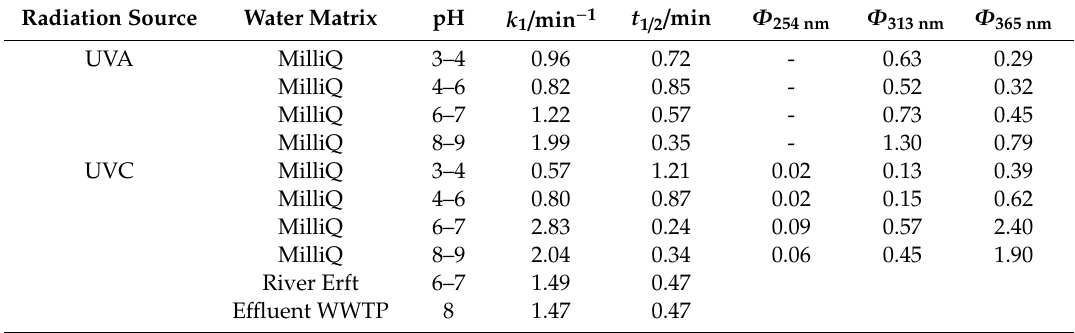
Table 2. Comparison of the kinetic rate constants, half-lives, and quantum e ffi ciencies at the wavelengths 254 nm, 313 nm and 365 nm obtained for UVA and UVC irradiated solutions of 20 mg L − 1 LOM in MilliQ, river Erft water, and e ffl